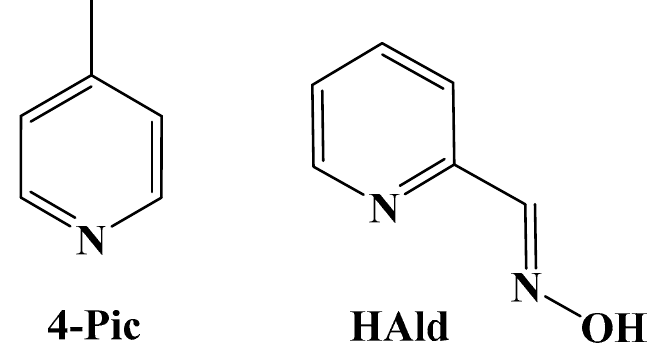
Figure 1. Structure of 4-picoline ( 4-Pic ) and pyridine-2-carboxaldoxime ( HAld